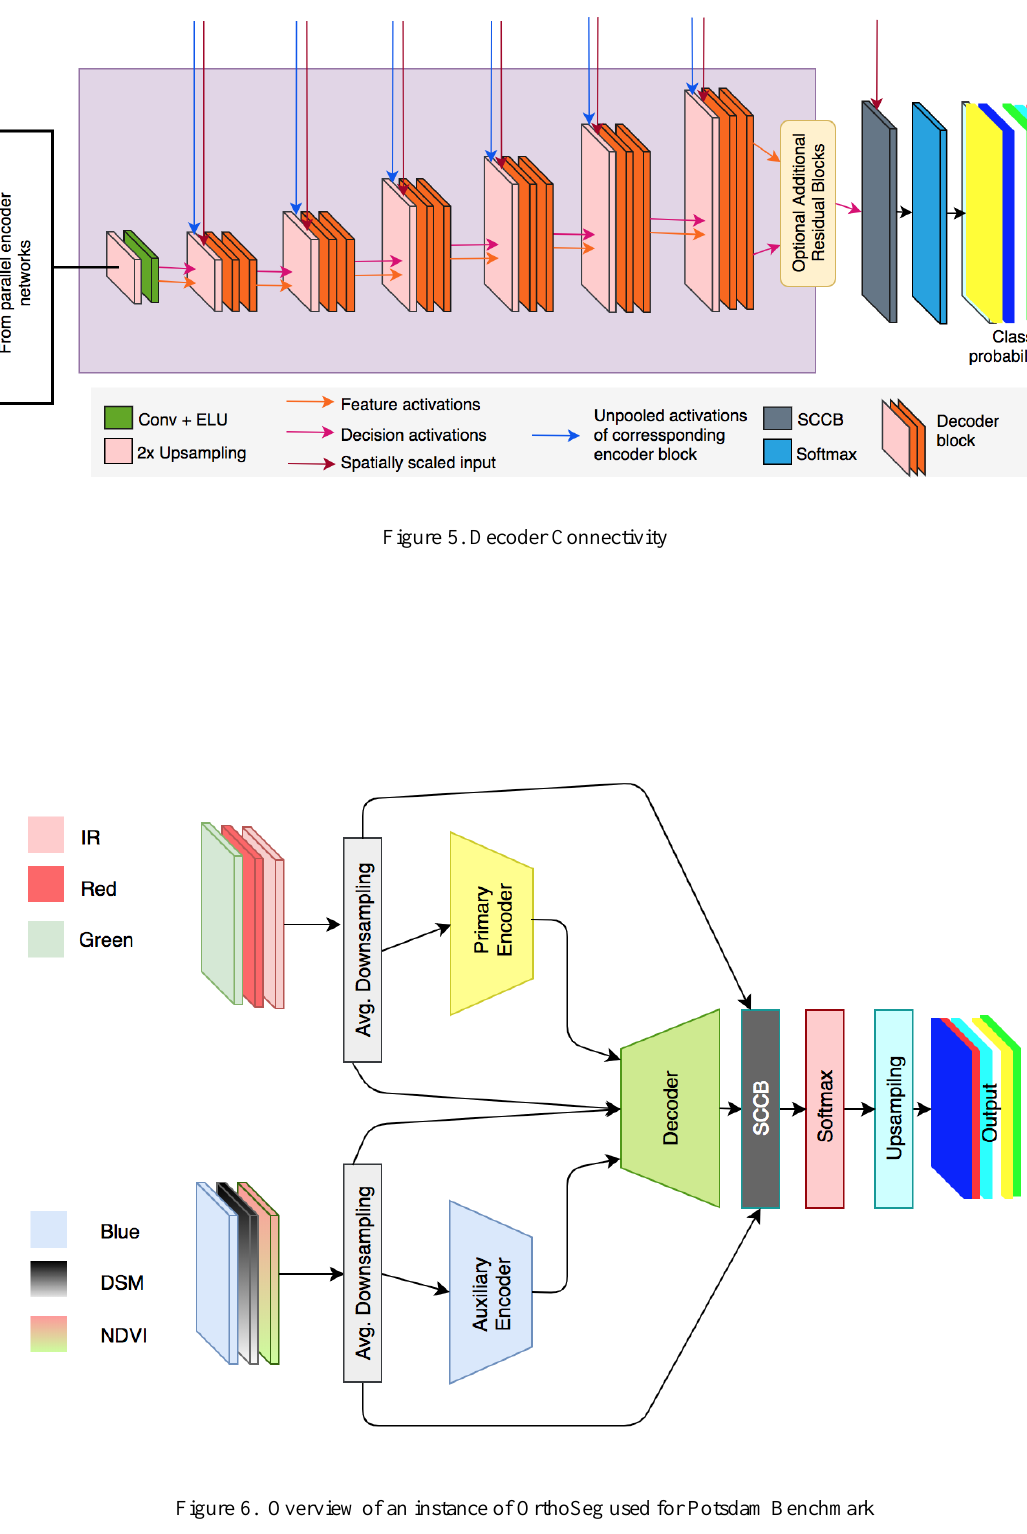
Figure 6. Overview of an instance of OrthoSeg used for Potsdam